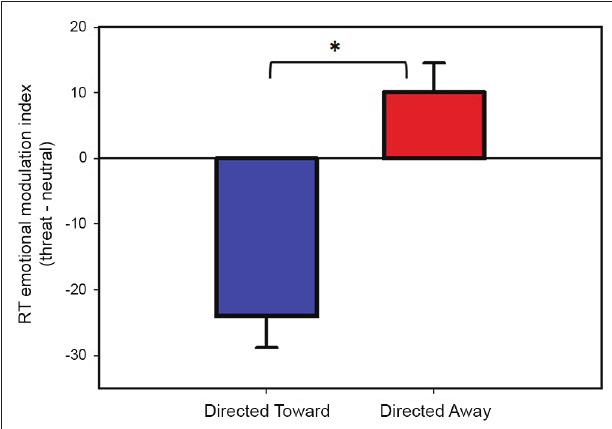
FIGURE 3 | Reaction time modulation by threat stimuli. Values represent the threat emotional modulation index (Threat-Neutral RT) per block. Both bars represent mean values in ms, and error bars indicate the SEM. Positive values of the emotional modulation index indicate that participants were slower in responding when threat stimuli were present than when neutral stimuli were present; negative values indicate that participants were faster in responding when threat stimuli were present than when neutral stimuli were present. * Indicates a significant